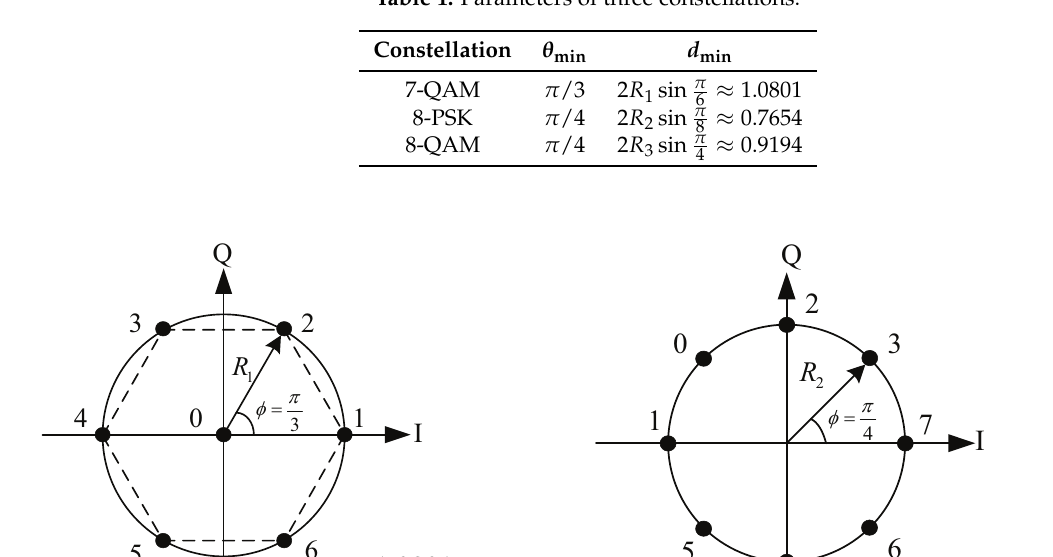
Table 1. Parameters of three constellations.